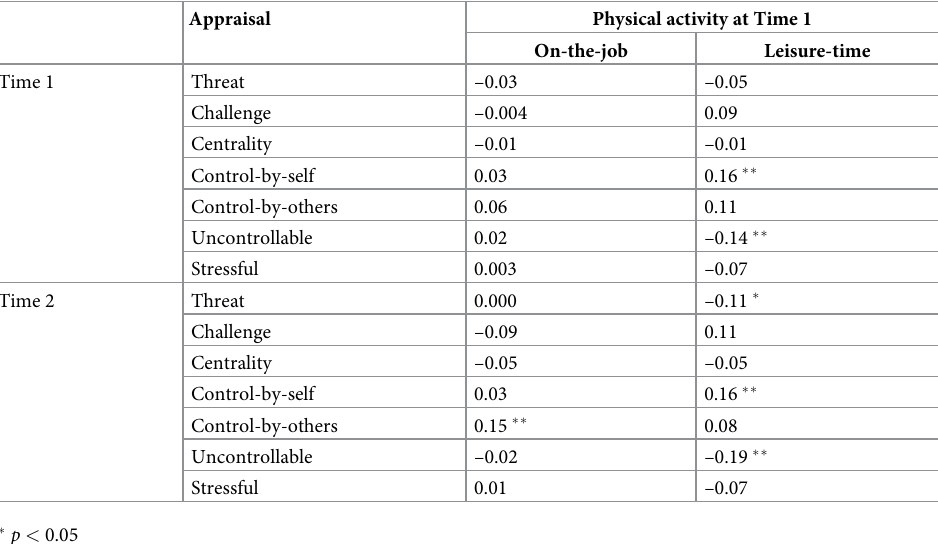
Table 2. Pearson correlations between physical activity at Time 1 and appraisals at Time 1 and Time 2 ( n = 319).